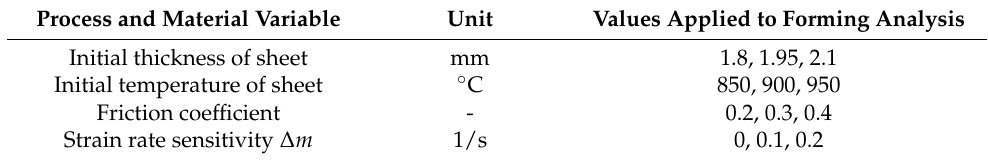
Table 4. Values of process and material variables considered for evaluating the effect on